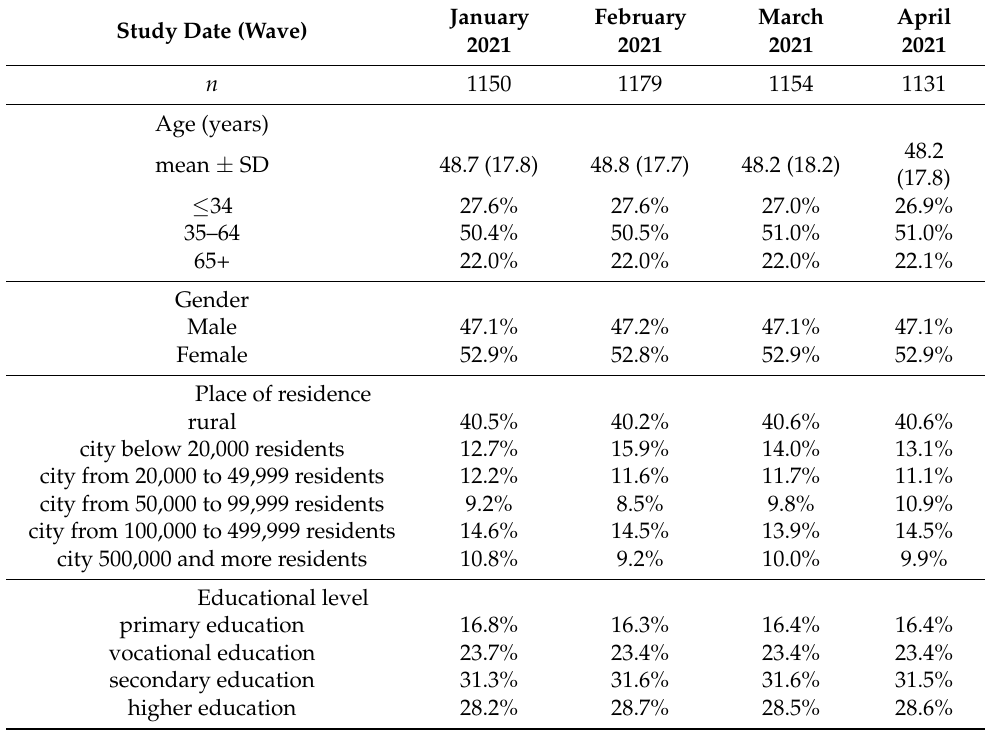
Table 2. Characteristics of the study population.